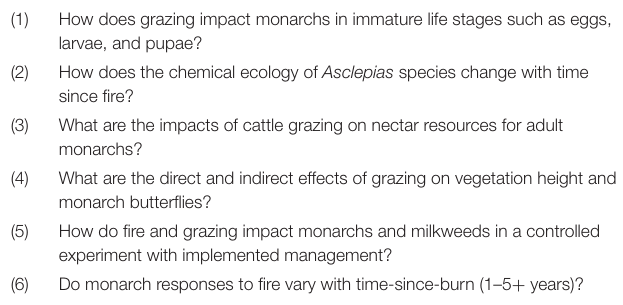
TABLE 5 | Recommendations for further research into the effects of fire and grazing on monarch